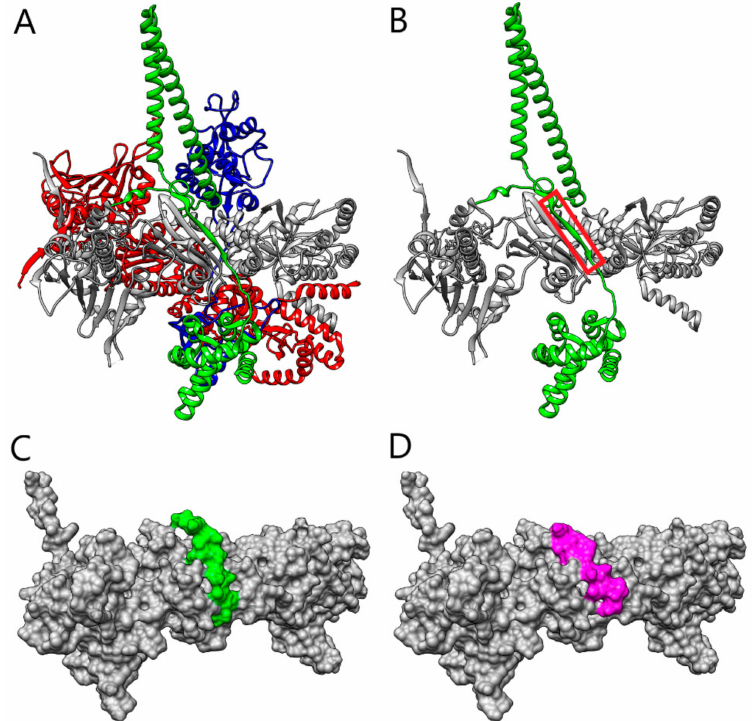
Figure 2. ( A ) The structure of Hsp90–Cdc37-Cdk4 complex (Hsp90 protomers A and B are in red and gray, respectively, Cdc37 is in green, and Cdk4 is in blue). ( B ) The structure of Hsp90B–Cdc37 (Hsp90B in grey, Cdc37 in green). The fragment of Cdc37 that was selected by the PepCrawler algorithm for the inhibitory peptide is marked in red. ( C ) The molecular surface of Hsp90B (grey), in the complex with the Cdc37p4 peptide retrieved by PepCrawler (green). ( D ) The molecular surface of Hsp90 (in grey), in complex with the Pep-Whisperer-designed peptide Cdc37p5